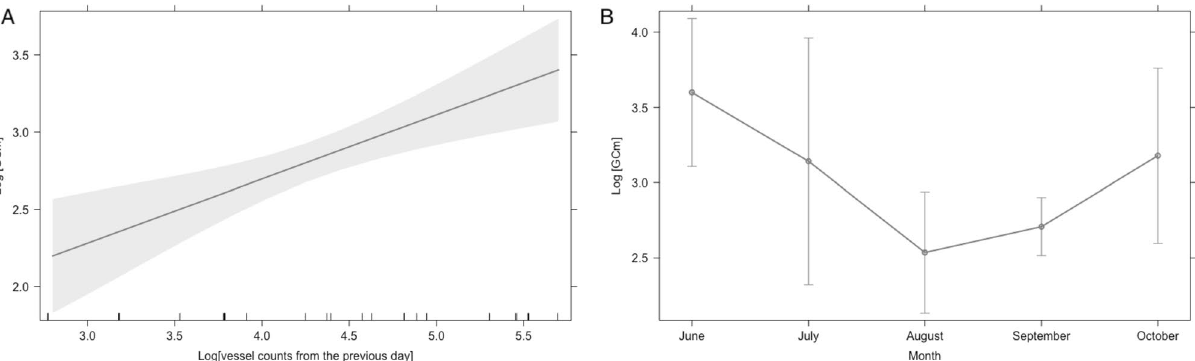
Figure 4. ( A ) The effect of vessel counts in Newport and Depoe Bay (Oregon, USA) on the day previous to fecal sample collection on gray whale fecal glucocorticoid metabolite (fGC) concentrations, derived from linear mixed model results with whale identification as random effect (Table 2; Model 2). ( B ) The effect of month on the gray whale fecal glucocorticoid metabolite (fGC) concentrations, also derived from linear mixed model results with whale identification as random effect (Table 2; Model 2). Data collected between May and October of 2016, 2017 and 2018. Asterisk indicates significant correlations between the variables in both A and B. Note difference in axes scales between A and B.